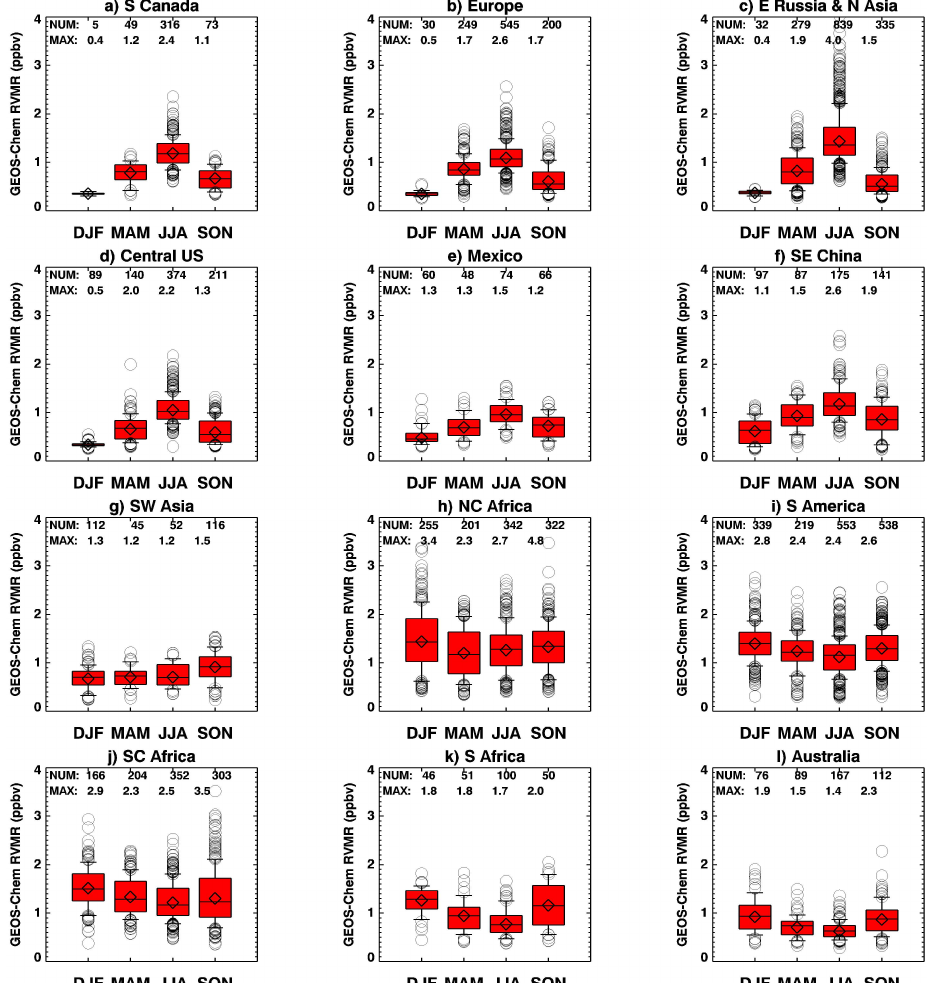
Fig. 14. Statistics of the GEOS-Chem CH 3 OH RVMR values in Fig. 11 for each region in Fig. 12. Plotting conventions are as in Fig. 13.